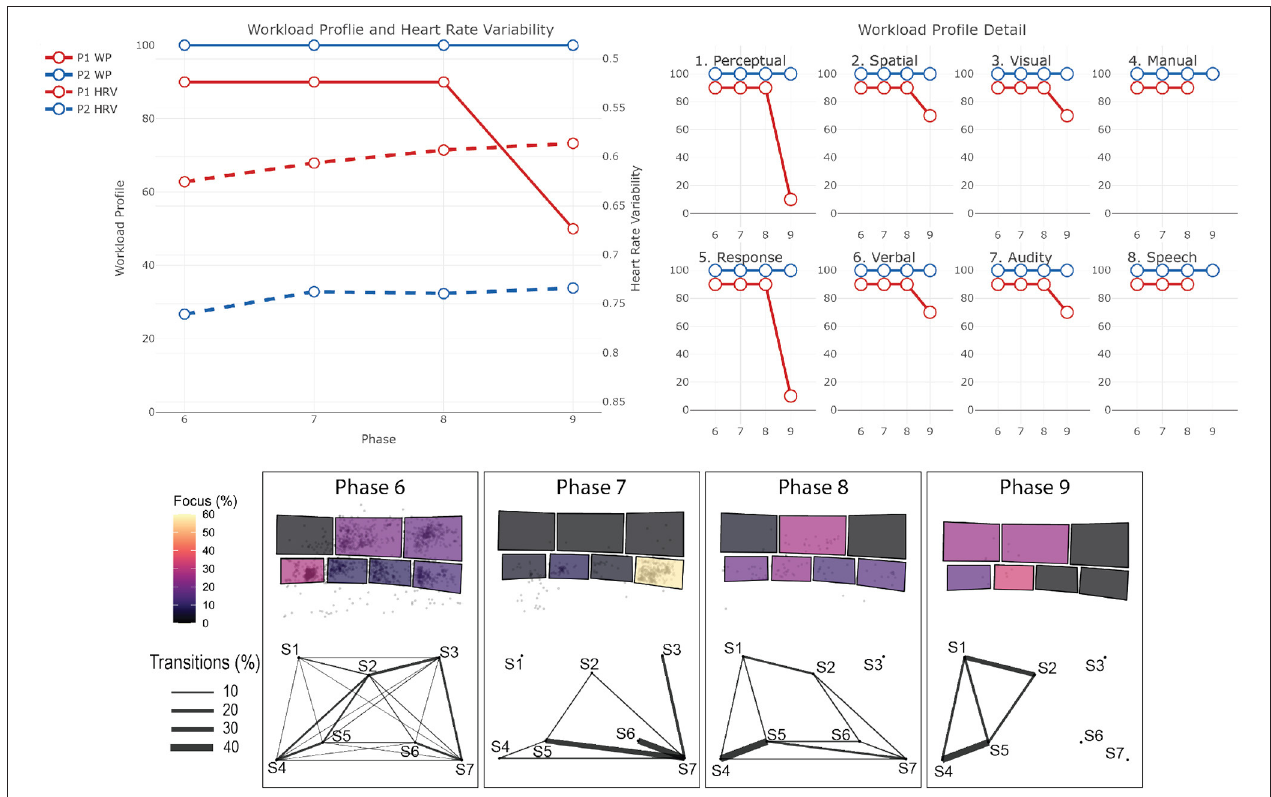
FIGURE 7 | Results for the second session of training 3. The top-left chart shows the evolution of the WP and HRV during the session for both participants (the axis of the HRV is inverted). The top-right chart shows the evolution of each criteria of the WP during the session for both participants. The bottom chart displays eye tracking data for P2 for each phase: at the top is the schematic representation of the operator’s workspace with a heatmap showing the amount of time the operator spent focusing on each screen; the bottom graph indicates the amount of transition between each of the screens with the thickness of the lines. The same organization is used in the following